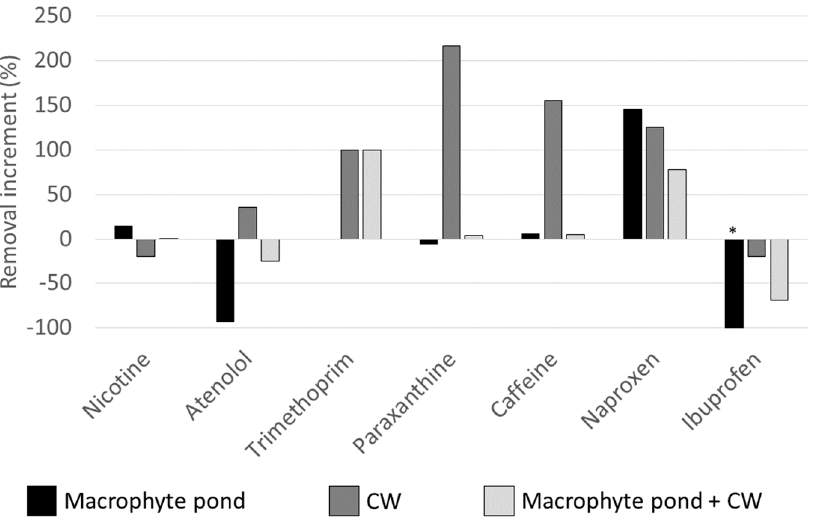
Figure 7. Increment (%) in average removals with effluent recirculation. * Removal increment: − 420%